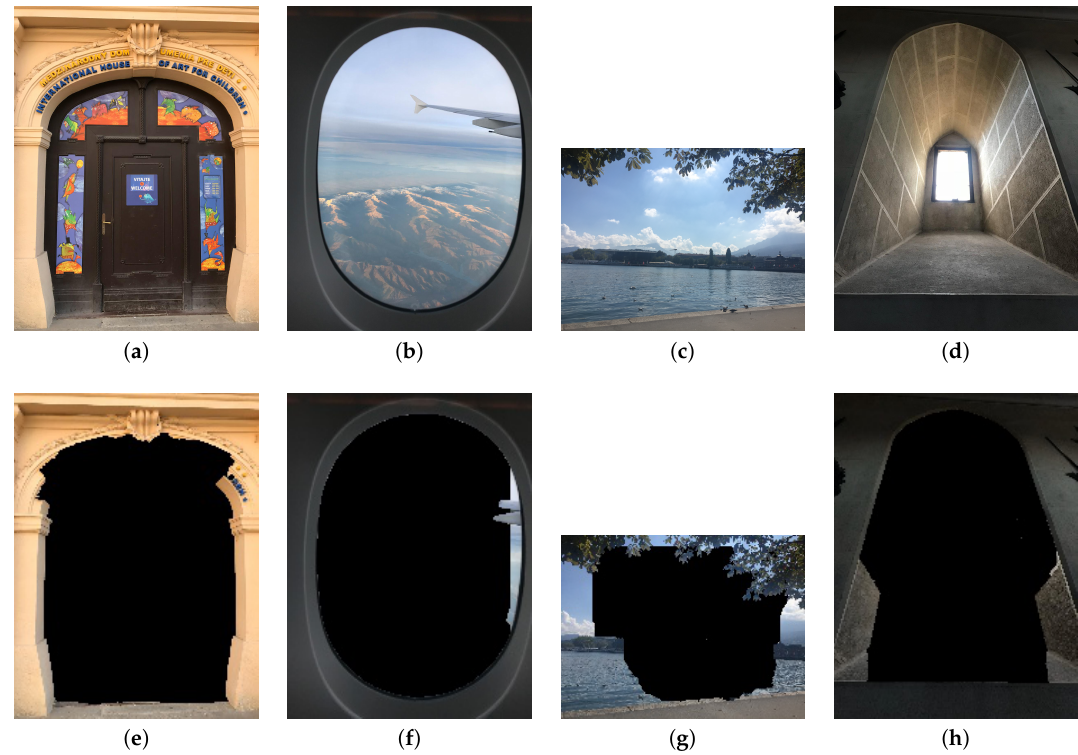
Figure 24. ( a – d ) Original images. ( e – h ) Foregrounds of ( a – d ), respectively.